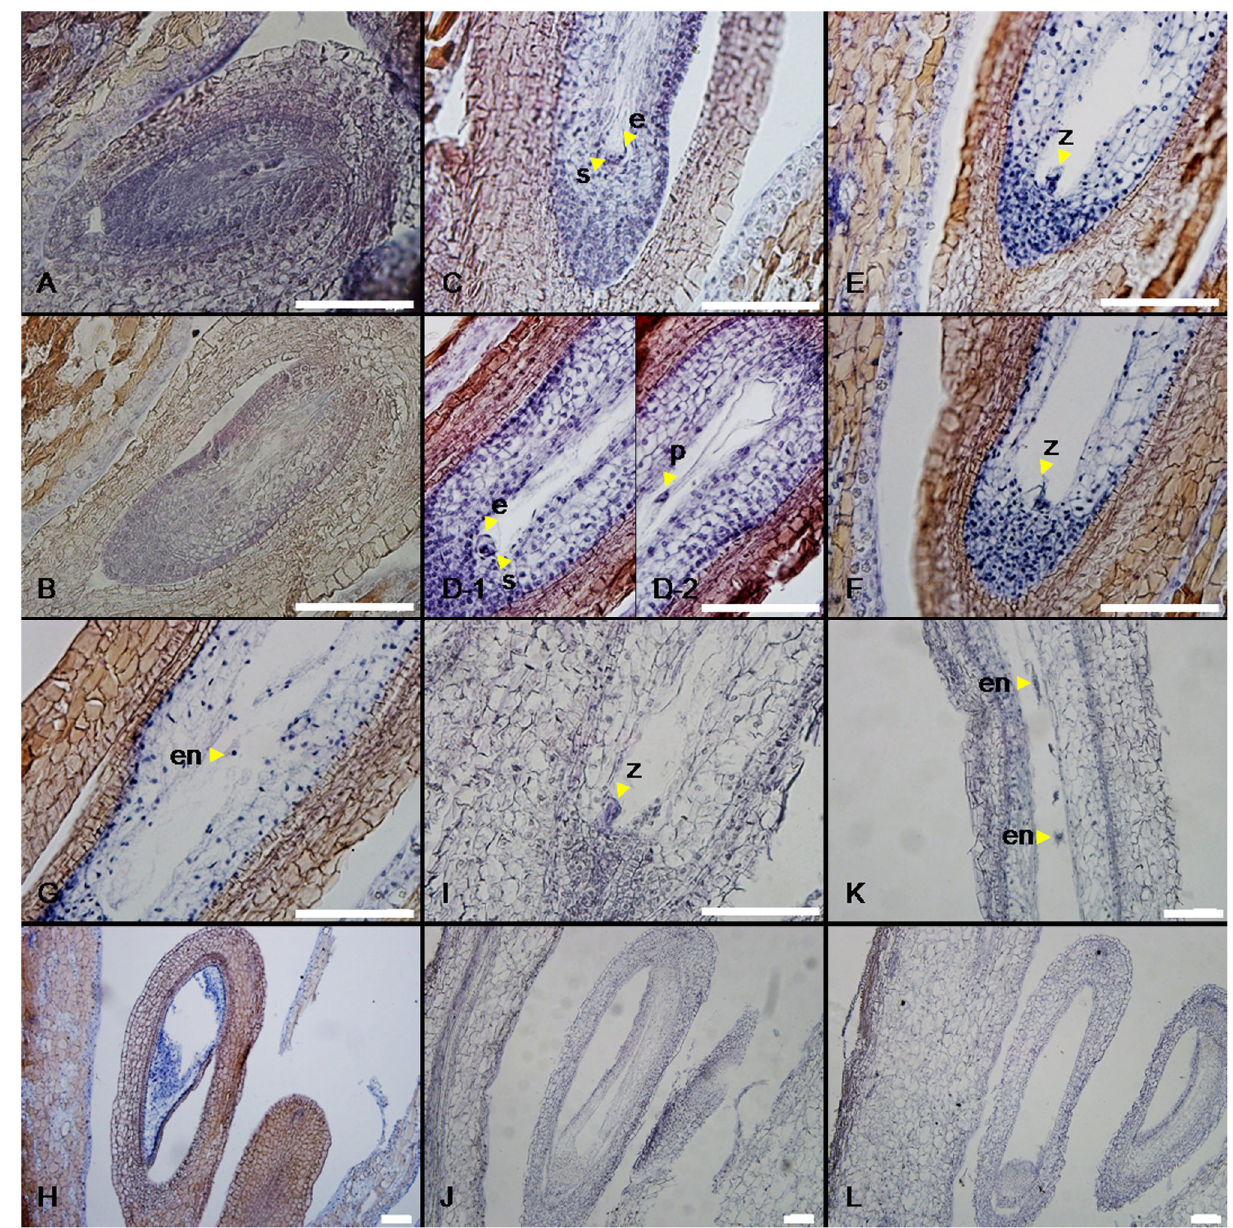
Figure 3. Seed development in untreated control and GA -treated ‘Thompson Seedless’ grape. (A and B) Normal embryo 3 sacs with macrospore cells from untreated control (A) and treated (B) ovules 5 days after treatment; (C and D) mitotic macrospore cell with premature embryo sac from untreated control (C) and an egg cell, two synergids and polar nucleus from treated ovule (D) 9 days after treatment (D-1 and D-2 were contiguous sections); (E and F) zygotes from untreated control (E) and treated (F) seeds 17 days after treatment (1 DAF); (G and H) abnormal endosperm nuclei from treated grape (G) and embryo with degrading embryo sac from treated grape (H) 17 days after treatment (1 DAF); (I and J) normal zygote from untreated control seed (I) and abnormal embryo sac from treated seed (J) 25 days after treatment (9 DAF); (K and L) endosperm nuclei from untreated control seed (K) and abnormal treated seed (L) 31 days after treatment (15 DAF). Scale bar = 100 μm, e: egg cell, en: endosperm nuclei, p: polar nucleus, s: synergid, z: zygote.